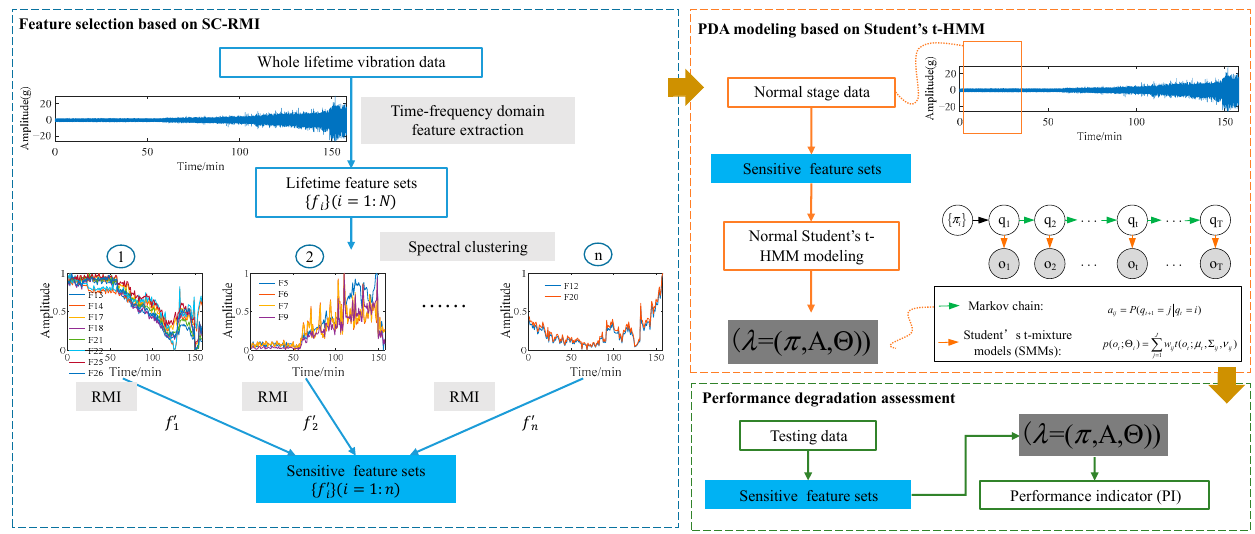
Figure 4. The whole frame of the proposed method.